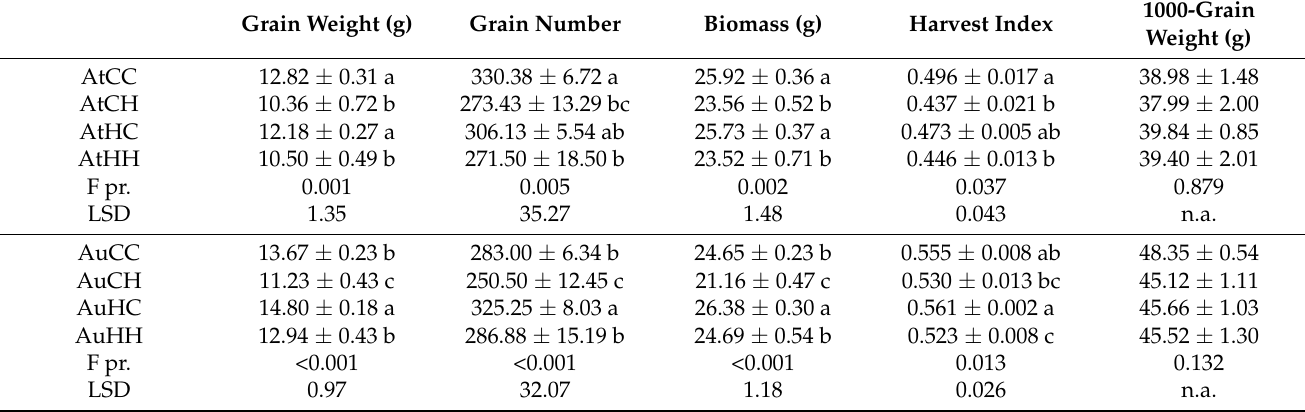
Table 1. Progeny yield performance under the effects of transgenerational and progeny heat stress. Means are shown with standard error ( n = 8). The letters (a, b, c) indicate significant statistical difference ( p < 0.05) across treatment groups within each variety. The treatment groups are: AuCC (DBA Aurora progeny treated with the control, originated from control group parents), AuCH (DBA Aurora progeny treated with heat stress, originated from control group parents), AuHC (DBA Aurora progeny treated with the control, originated from heat stress group parents), AuHH (DBA Aurora progeny treated with heat stress, originated from heat stress group parents), AtCC (DBA Artemis progeny treated with the control, originated from control group parents), AtCH (DBA Artemis progeny treated with heat stress, originated from control group parents), AtHC (DBA Artemis progeny treated with the control, originated from heat stress group parents), AtHH (DBA Artemis progeny treated with heat stress, originated from heat stress group